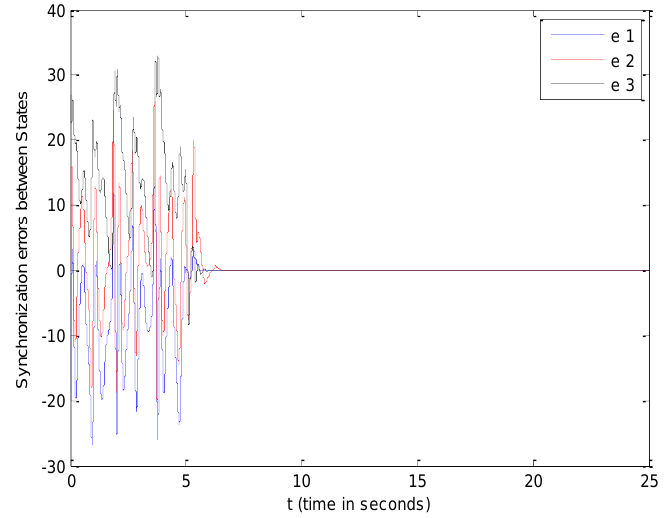
Figure 1. Synchronization error between the states of master and slave systems with 𝛼 𝑖 = 0.9, i = 1, 2, and 3, and time delay 𝜏 = 5 s.